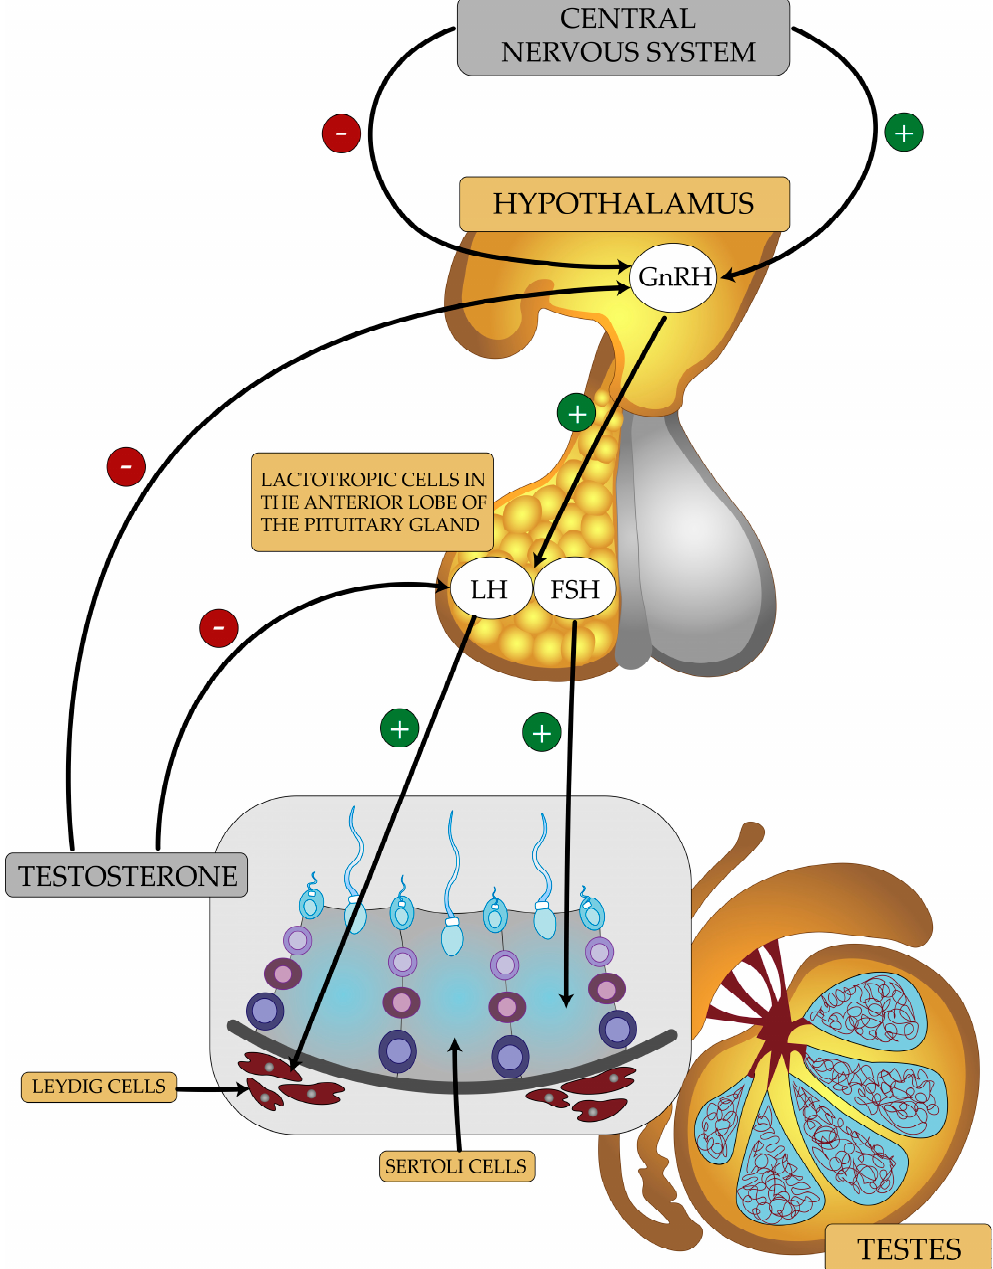
Figure 2. A diagram illustrating the basis for the functioning of the HPG axis in men.